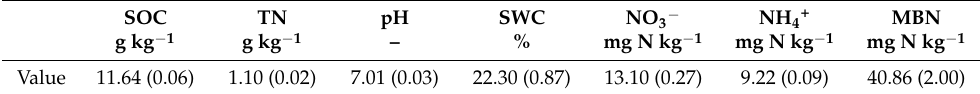
Table 1. Selected initial properties of soil used in the pot